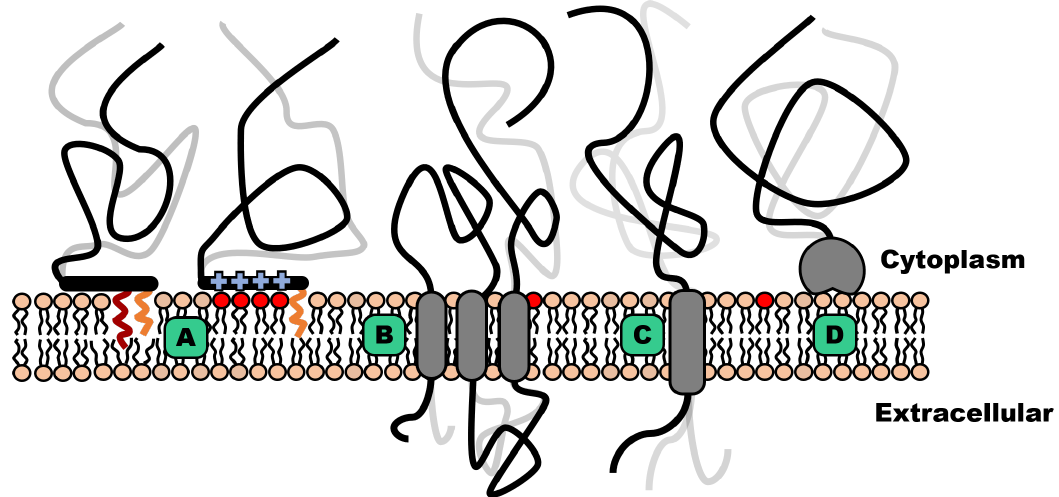
Figure 2: Anchoring of IDRs to the membrane surface. A. Lipid anchors. B. Polytopic membrane proteins. C. Single pass integral proteins. D. Attachment based on globular lipid binding